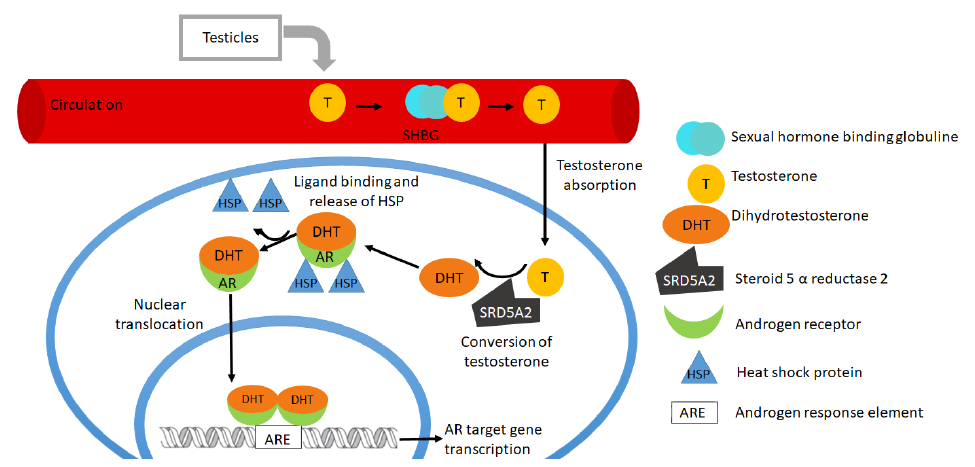
Figure 1. Genomic androgen receptor pathway.